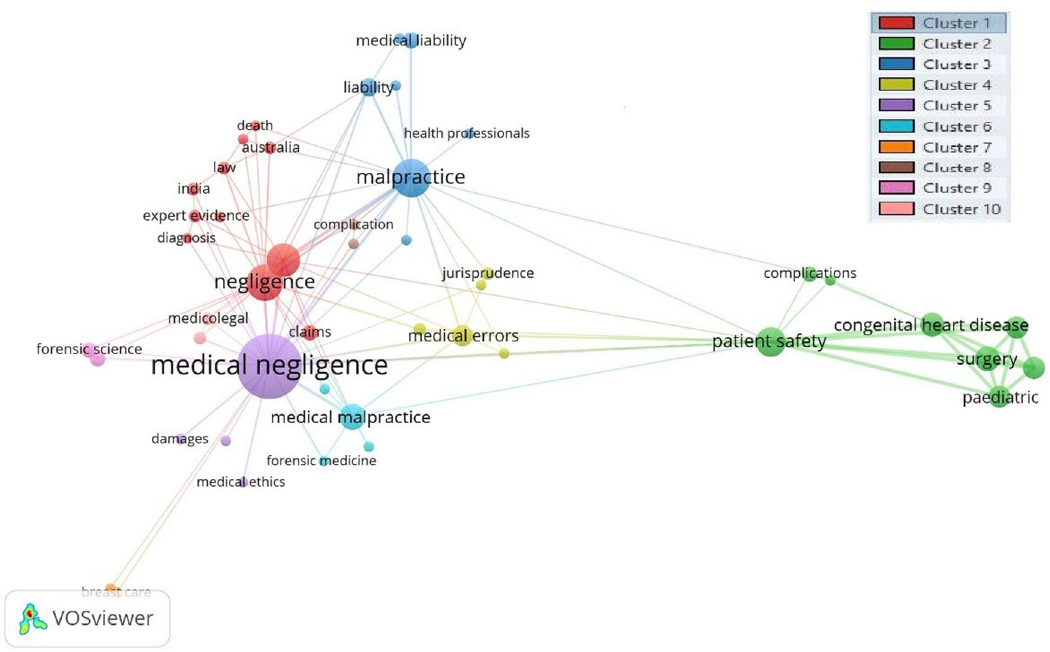
Figure 2. Author